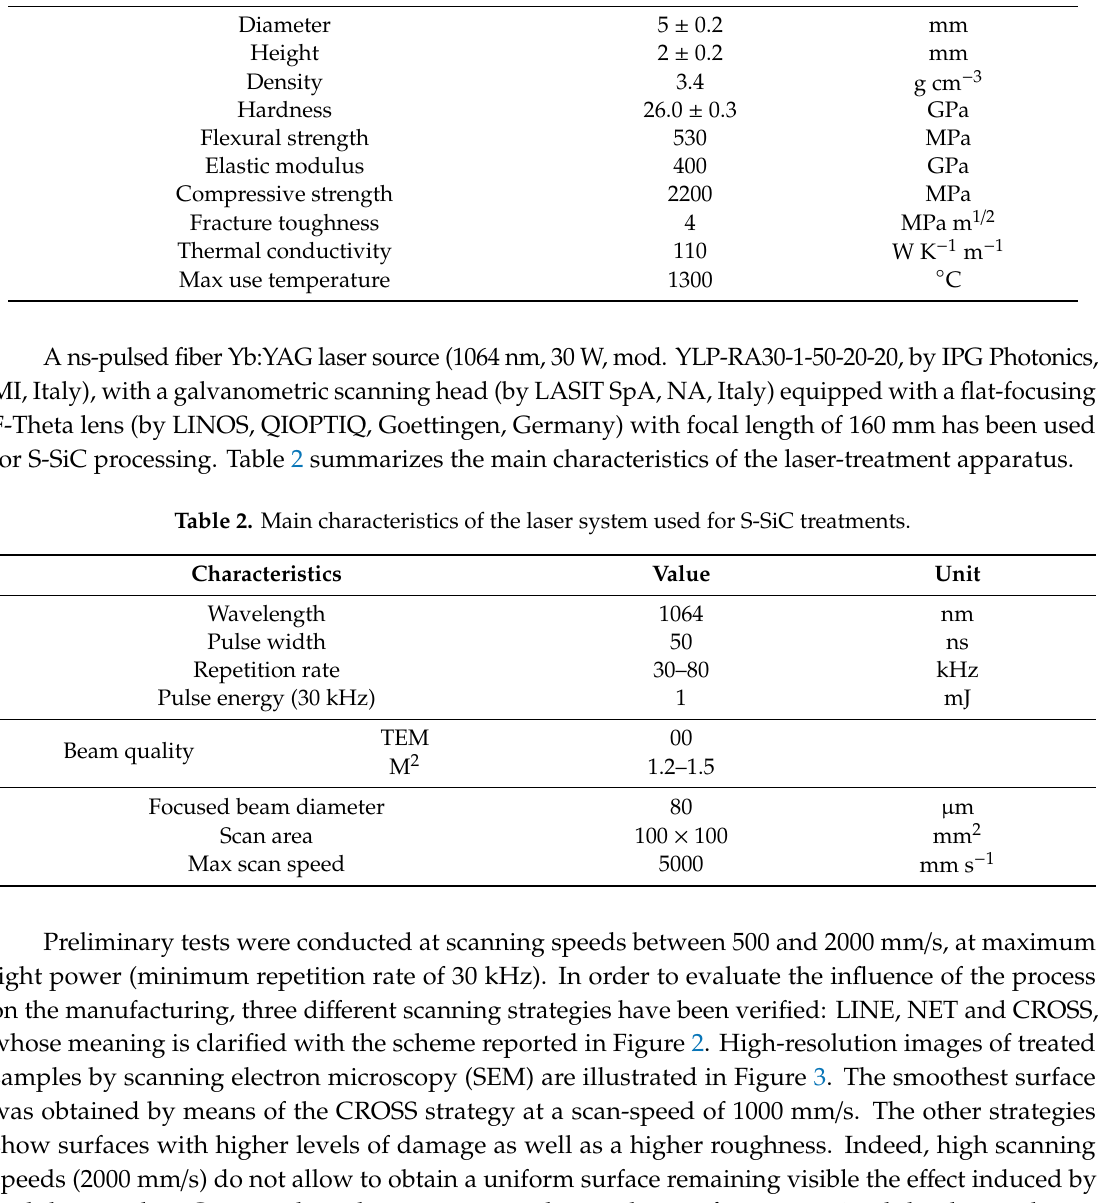
Table 1. Main characteristics of Sintered Silicon Carbide (S-SiC) samples used in this work. Characteristics Value Unit Composition